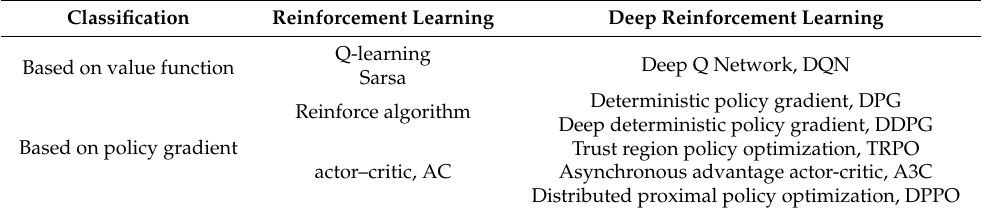
Table 1. The classification for typical reinforcement learning (RL) and deep reinforcement learning (DRL)